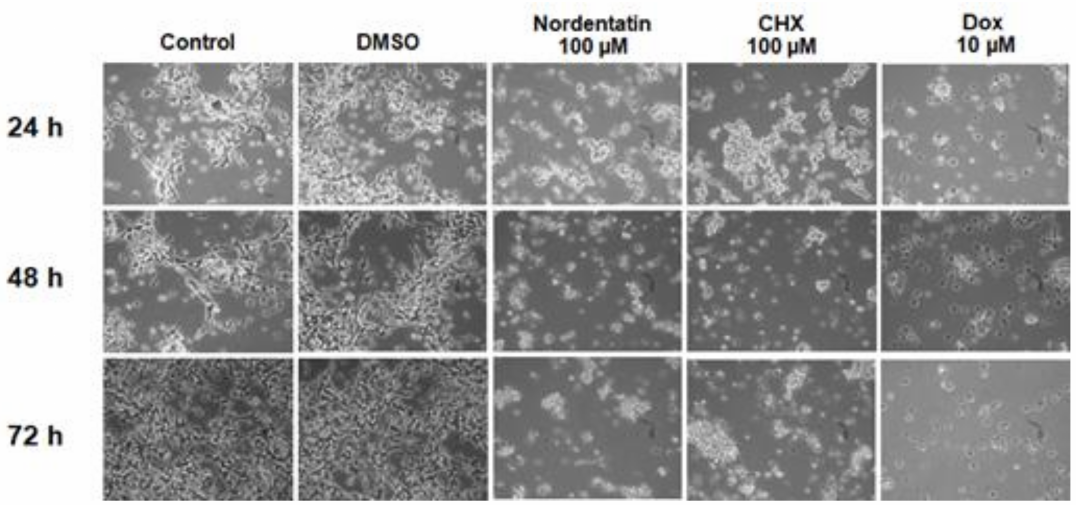
Figure 2. The morphology of SH-SY5Y neural cancer cells treated with chemicals derived from Song-fa as under a phase-contrast microscope.